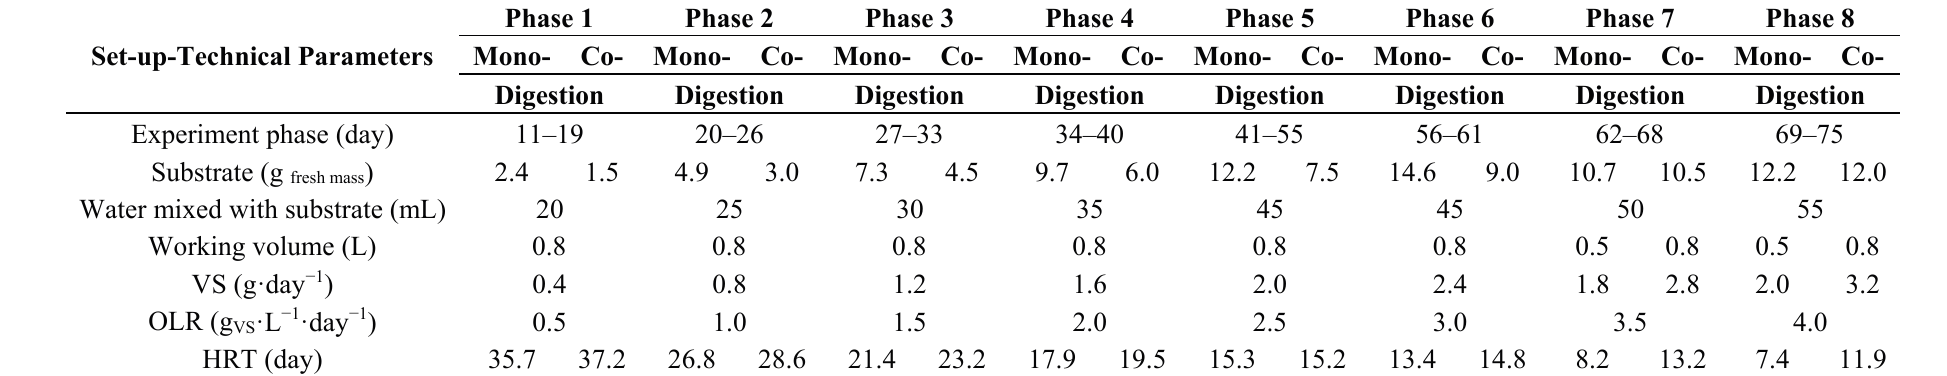
Table 2. Technical parameters during the experiment set-up of the mono- and co-digestion of filter cake and